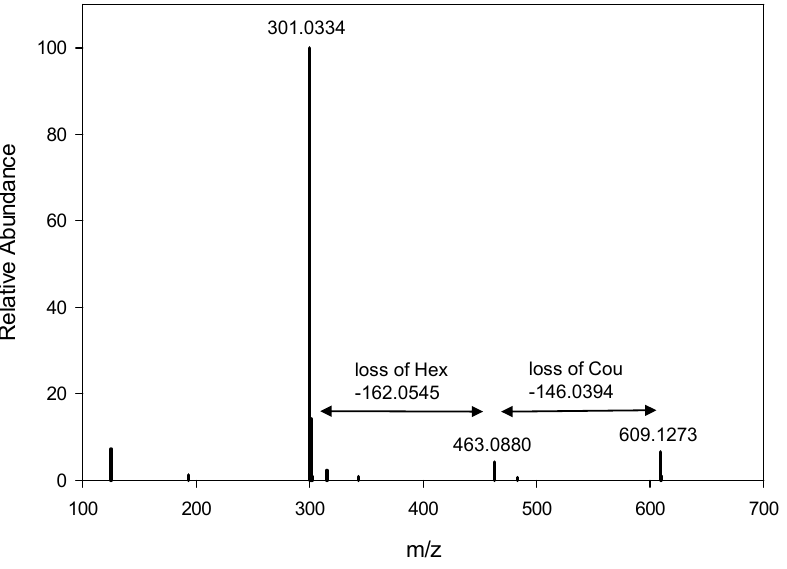
Figure 3. MS fragmentation spectrum of Dp ‐ Cou ‐ Hex in the ESI negative ionization mode shows an additional fragment at m / z = 463.0880, which confirms the presence of the coumaroyl moiety. Anthocyanins were present in purple tea leaves at much higher